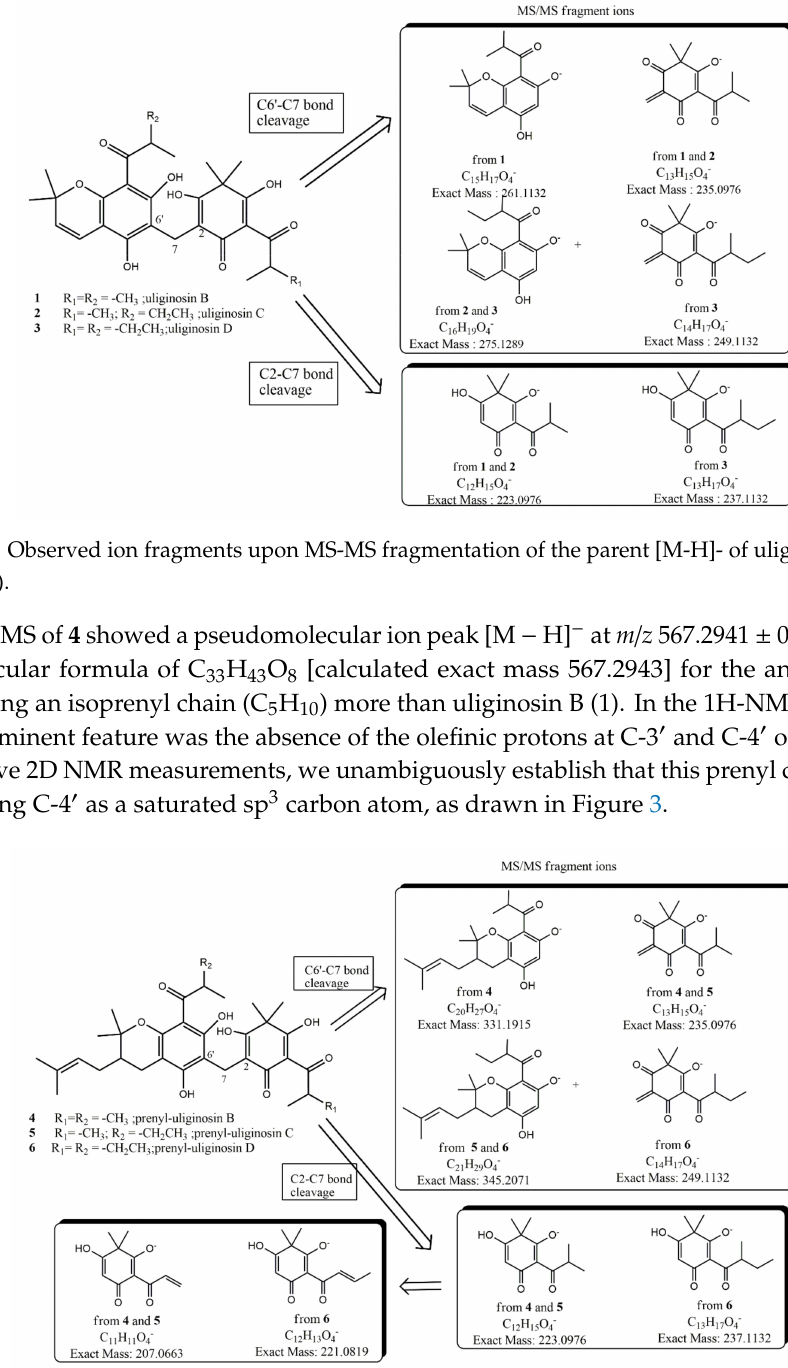
Figure 3. Observed ion fragments upon MS-MS fragmentation of the parent [M − H] − of prenyl-uliginosins B(4), C(5), and